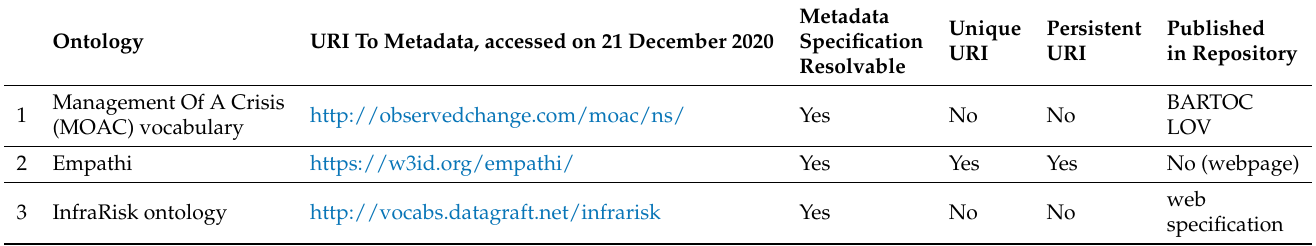
Table 7. Metadata Specifications for Ontology Artefacts within the Disaster Domain.